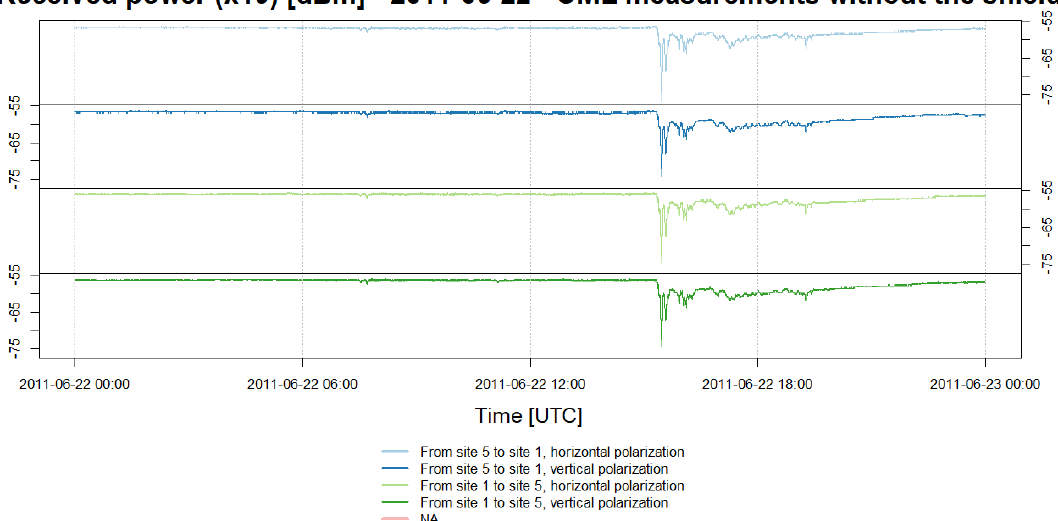
files were organized as described in Appendix F.